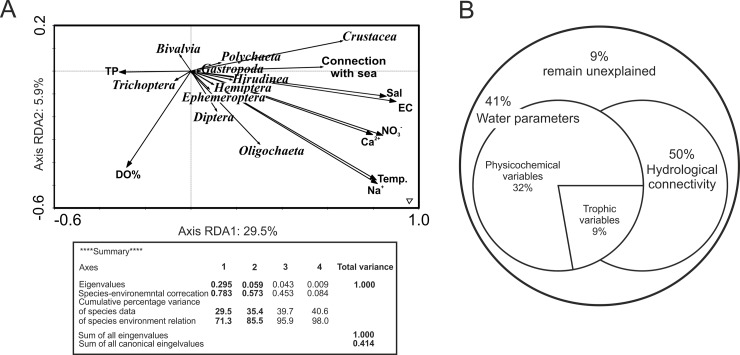
Results of redundancy analysis (RDA): (A) a biplot of significant environmental variables and zoobenthos density (p < 0.05); (B) unique and shared fractions (Bio-Env procedure) of the total variation of zoobenthos composition, explained by hydrological connection with the sea and the contribution of physico-chemical and trophic parameters of water.